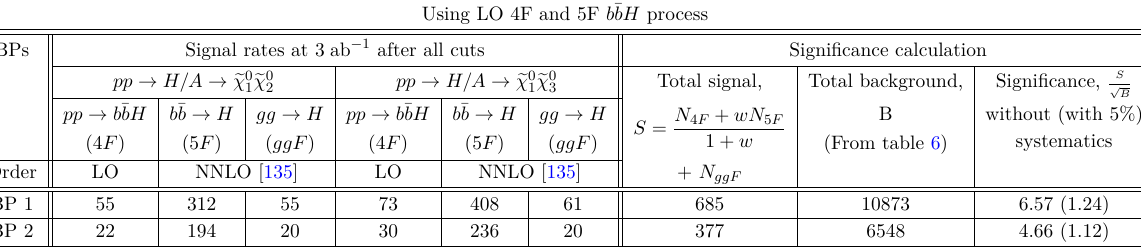
Table 7. The signal yield along with signal significance for the b-veto category of ‘‘ + /E state. N ggF , N 4 F , N 5 F are the total event yield from the gluon fusion, 4 F , 5 F production processes respectively. The N 4 F and N 5 F are later added according to the Santander matching as described in the